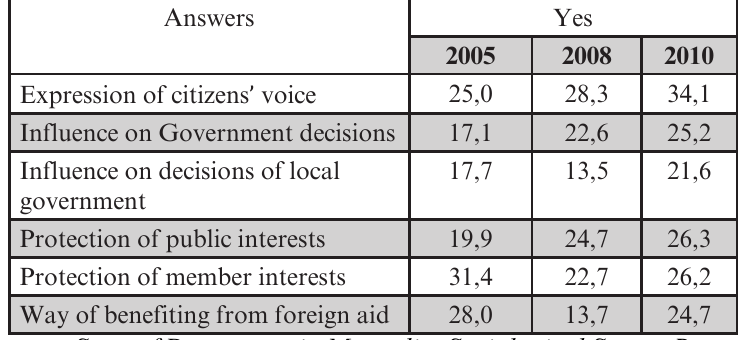
Table 8. Have NGOs been capable to carry out their roles and duties in the society?